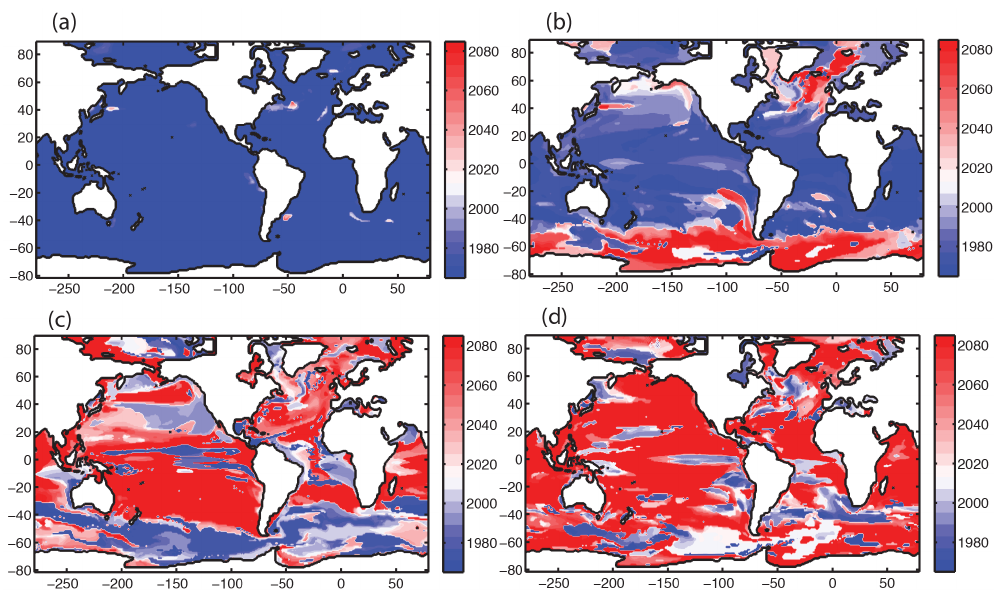
Figure 6. Time of emergence (ToE), calculated using a threshold of 1 standard deviation (67% confidence) for (a) (cid:127) arag , (b) SST, (c) O 2 inventories, and (d) NPP. The color scheme has been chosen to distinguish between relative to the present (2014) with shades of blue indicating a ToE post-2014 and shades of red indicating a ToE